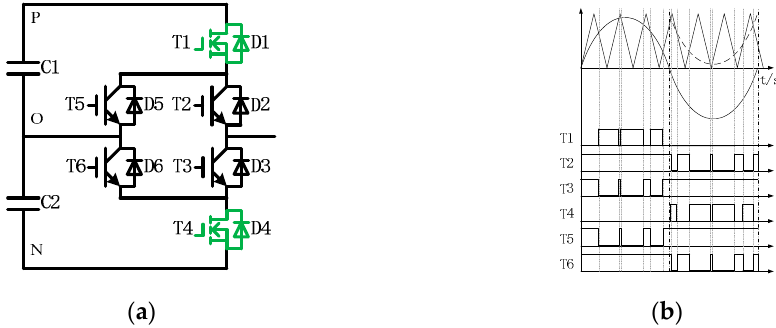
Figure 1. Proposed topology and modulation strategy waveform: ( a ) Proposed hybrid ANPC topology; ( b ) Proposed modulation strategy waveform.